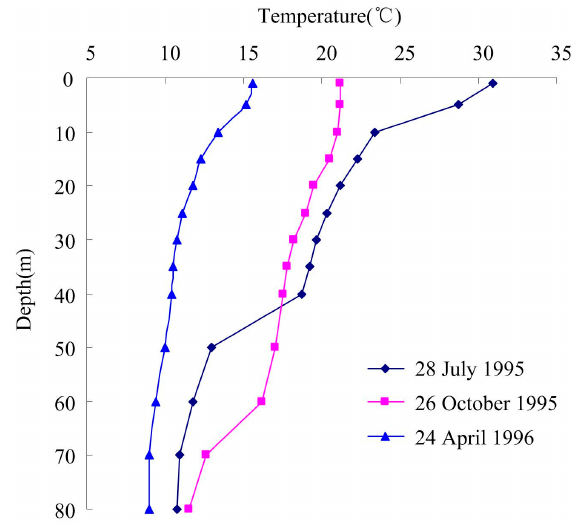
Figure 4. Vertical water temperature distribution in the Geheyan reservoir on three dates (spring, summer and autumn). The water temperature distribution is stratified in vertical dimension and the pattern is different at different time.